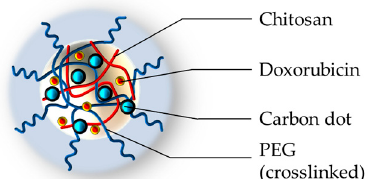
Figure 6. Graphic representation of PEG-chitosan-(carbon dots) hybrid nanogel [78].